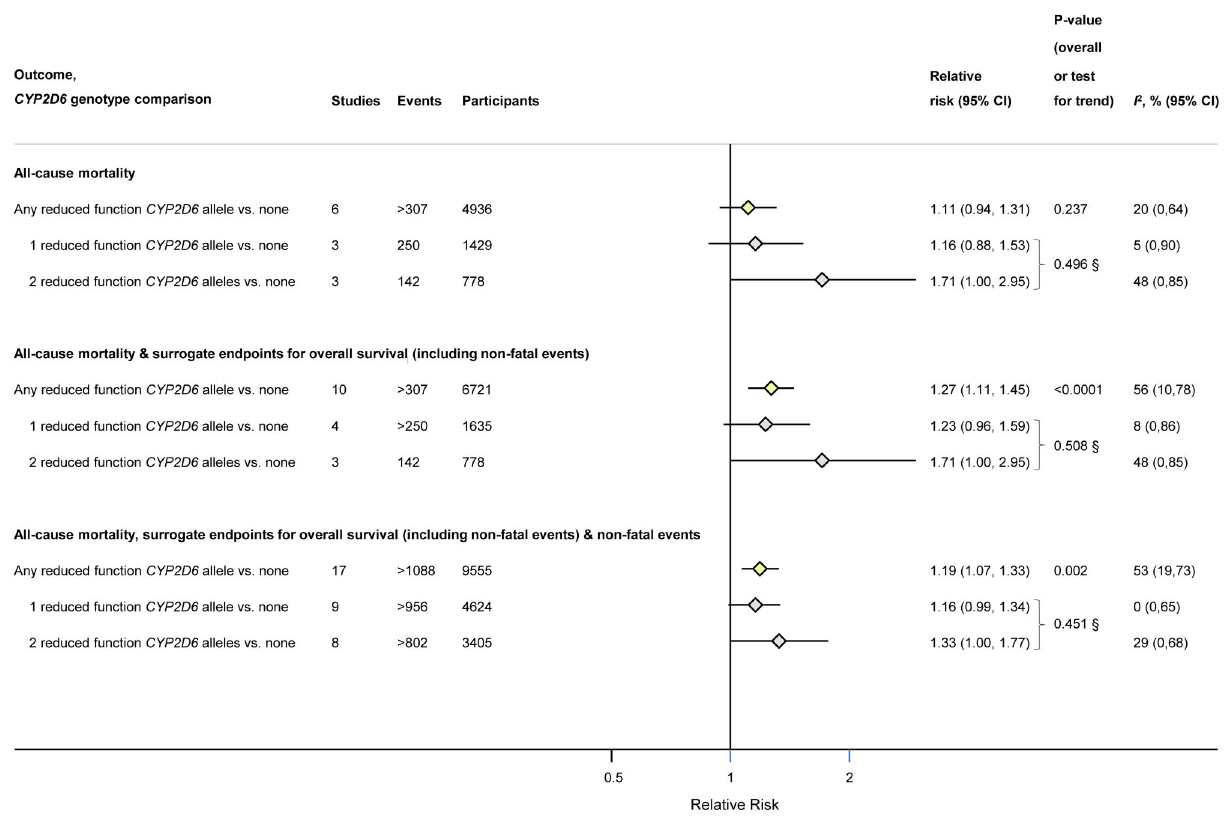
Figure 1. Meta-analysis pooled estimates from treatment-only analysis of the association of any, one or two copies of a reduced function CYP2D6 allele vs. none with composite breast cancer outcomes. Footnotes: § P-value represents test for trend, conducted using metaregression assuming a linear dose-response relationship between number of CYP2D6 alleles and summary effect estimate. doi: